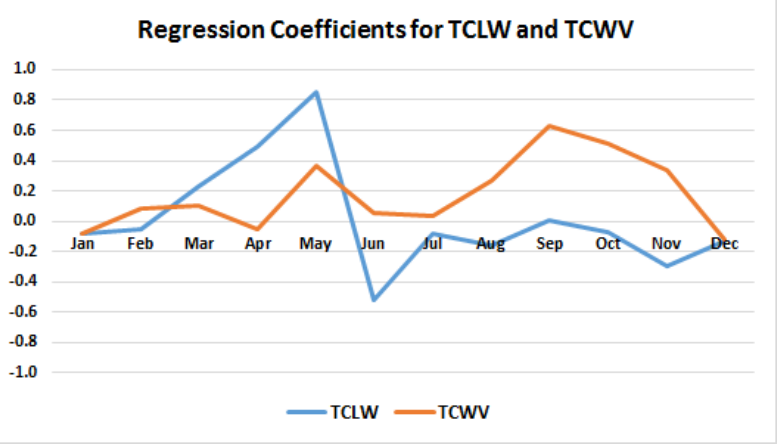
Figure 5. Monthly changes of regression coefficients for the total column liquid water (TCLW) and the total column water vapor (TCWV) during